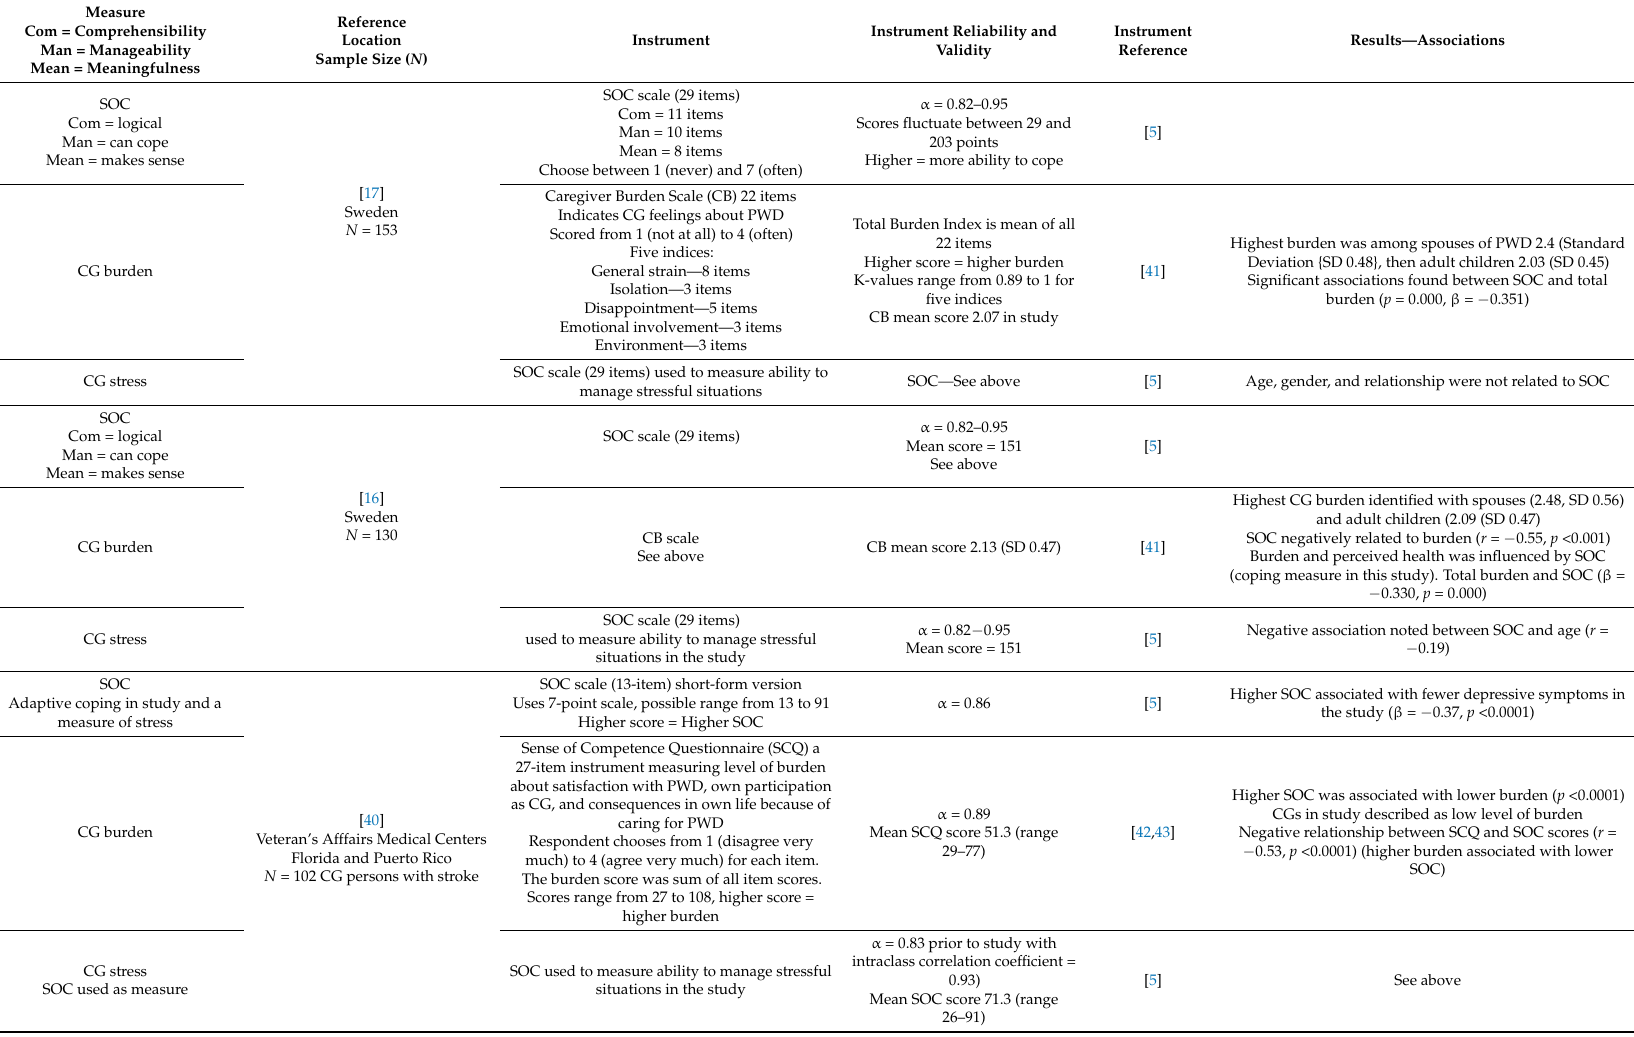
Table 2. Sense of Coherence (SOC) and Caregiver (CG) burden and